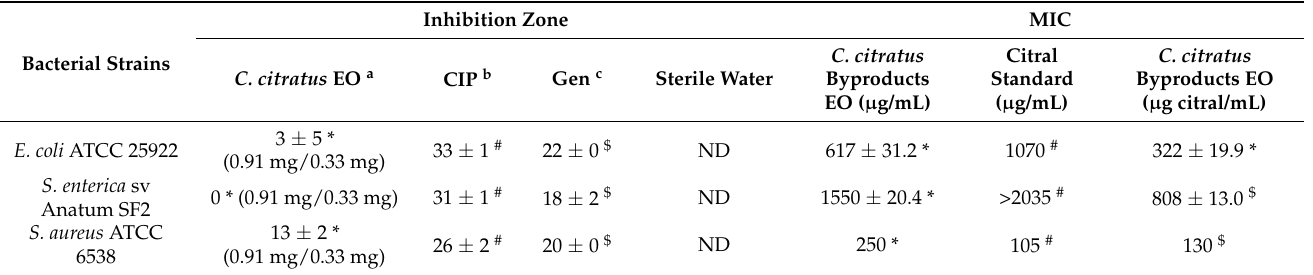
Table 2. Inhibition zones (mm) and minimal inhibition concentration ( µ g/mL) of C. citratus byprod- uct